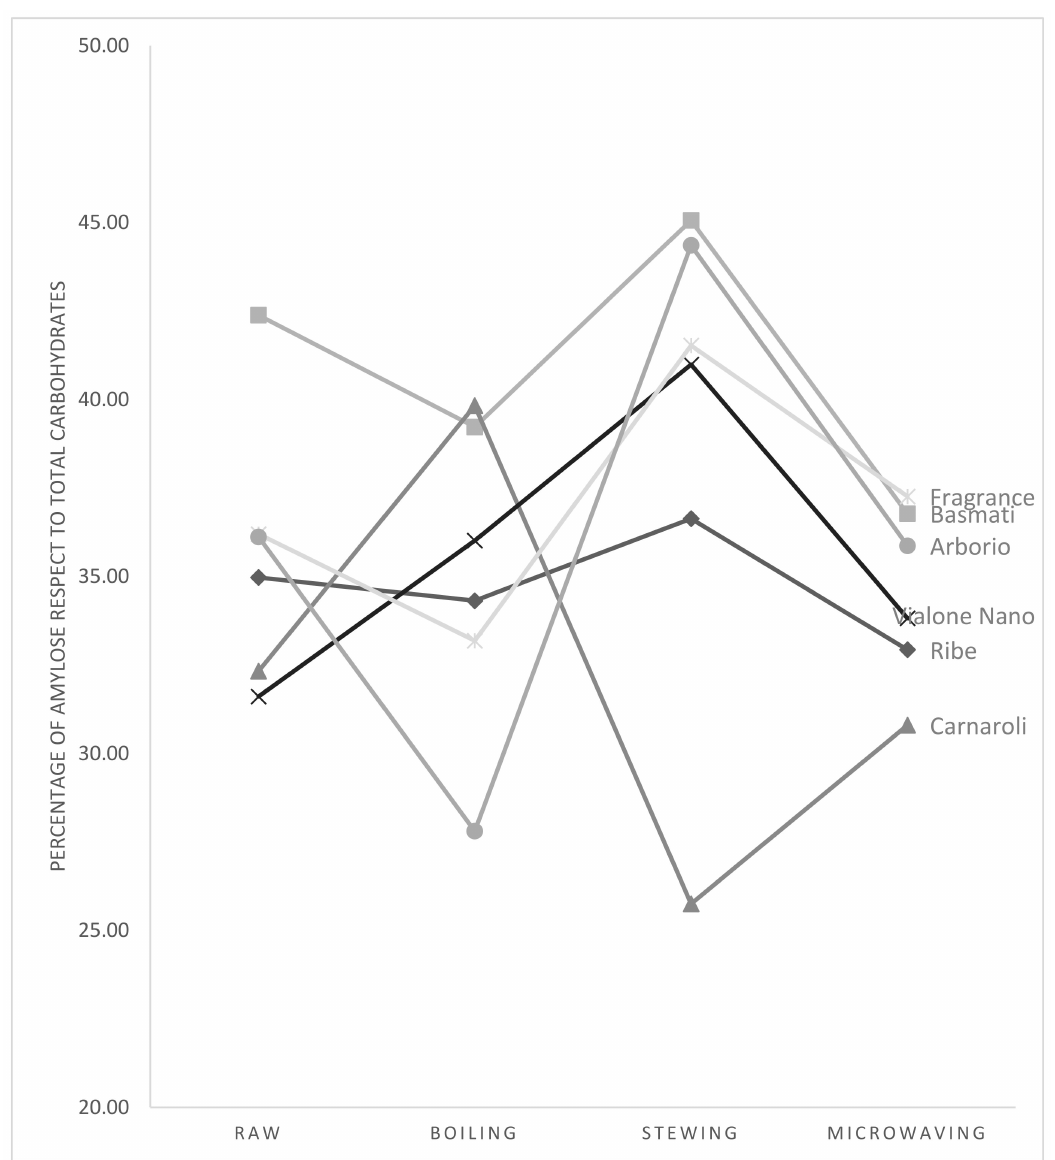
Figure 1. Graphical representation of amylose percentage with respect to total carbohydrate changes depending on cooking methods and rice